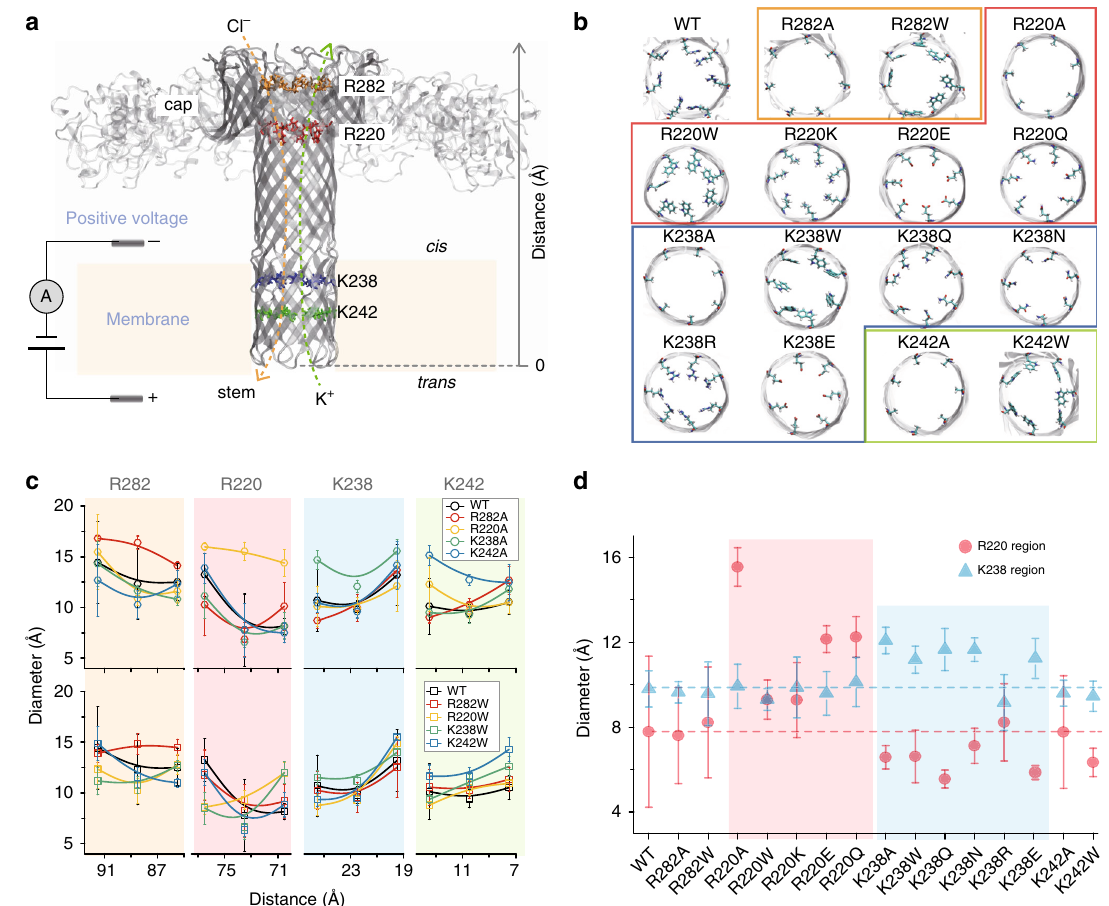
Fig. 1 Structural characterization of aerolysin nanopore variants. a Structural model of aerolysin nanopore based on cryo-EM data 14,15 . The amino acids at the sensing regions are shown as sticks and colored as follow: R282 (orange), R220 (red), K238 (blue), and K242 (green) 40 . MD simulations were performed on a truncated pore model (i.e., residues 195 – 300 and 409 – 424, highlighted in solid dark gray). Here a typical simulation system is represented with positive applied voltage, i.e. a negative potential is applied at the cap side ( cis ) and a positive potential at the stem side ( trans ). The bottom of the pore is used as reference 0 Å distance in all the graphs. b Top view of the wt and mutants pore lumen. For wt, the view is focused at R220, and for the mutants, at the mutated region. c The diameter of wt and engineered aerolysin nanopores calculated with the PoreWalker server 35 . Distance ~88.5 Å represents the R282 position at the cap region, while a distance of ~73.5 Å indicates R220 also at the cap; ~22.5 Å corresponds to K238 at the stem, and ~10.5 Å is the K242 position also at the stem region. Each point represents the mean value ± st. dev. of at least 10 distinct structures extracted from MD simulations. d Calculated diameter of the various mutants at the two main sensing regions for 220 (red circles) and 238 (blue triangles)